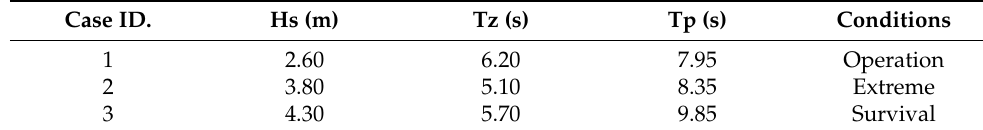
Table 1. Typical parameters for waves and environmental conditions. Case ID.